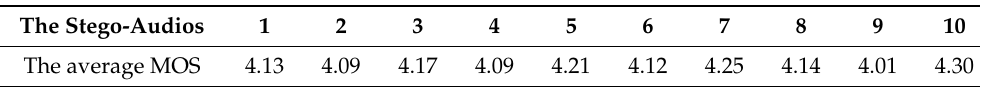
Table 4. The average MOS of ten randomly selected stego-audios generated by this model with a post-processing